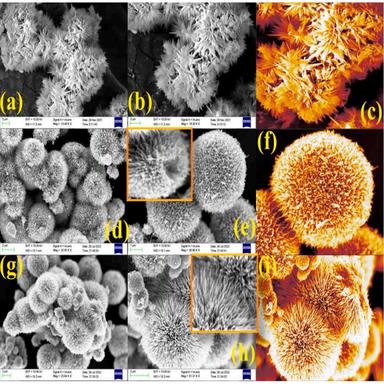
SEM images of NiCoP (a-c), NiCoP/WSe2 (d-f) and NiCoP/WSe2@ZnS (g-i).